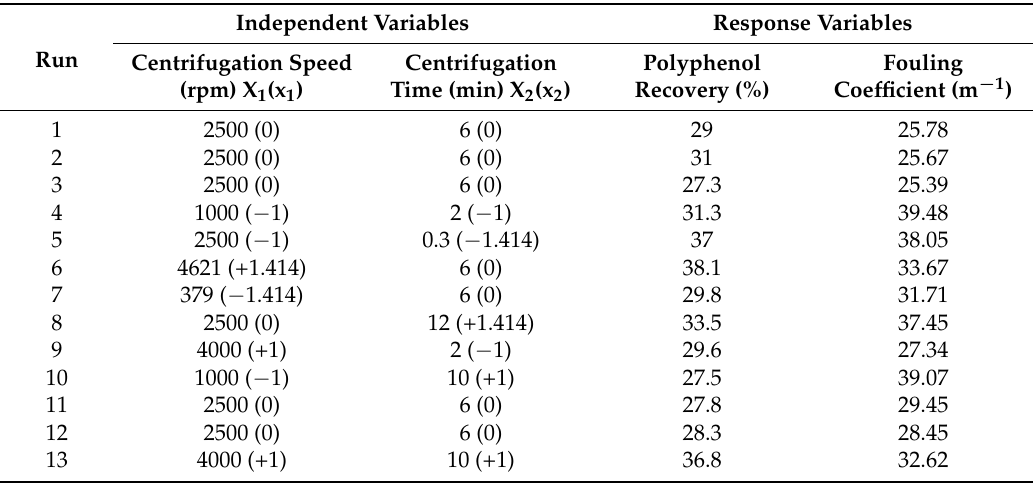
Table 4. RSM design and its experimental